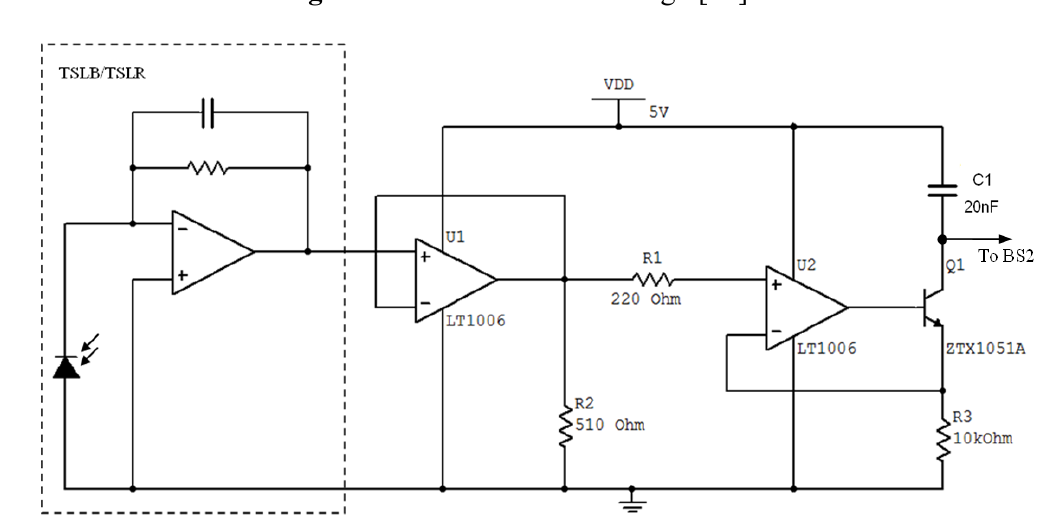
Figure 7. Detector Circuit Design